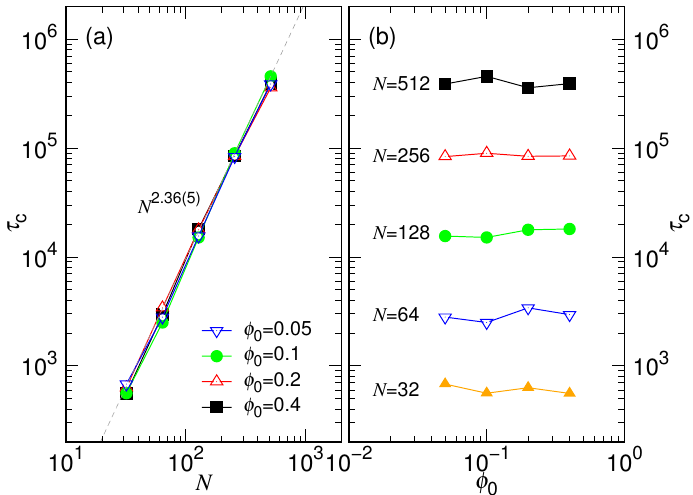
Figure 8. ( a ) τ c vs. N for a given φ 0 . The value of φ 0 can be read in the legend. ( b ) τ c vs. φ 0 at a fixed N . The chain length N is indicated near the corresponding curve.